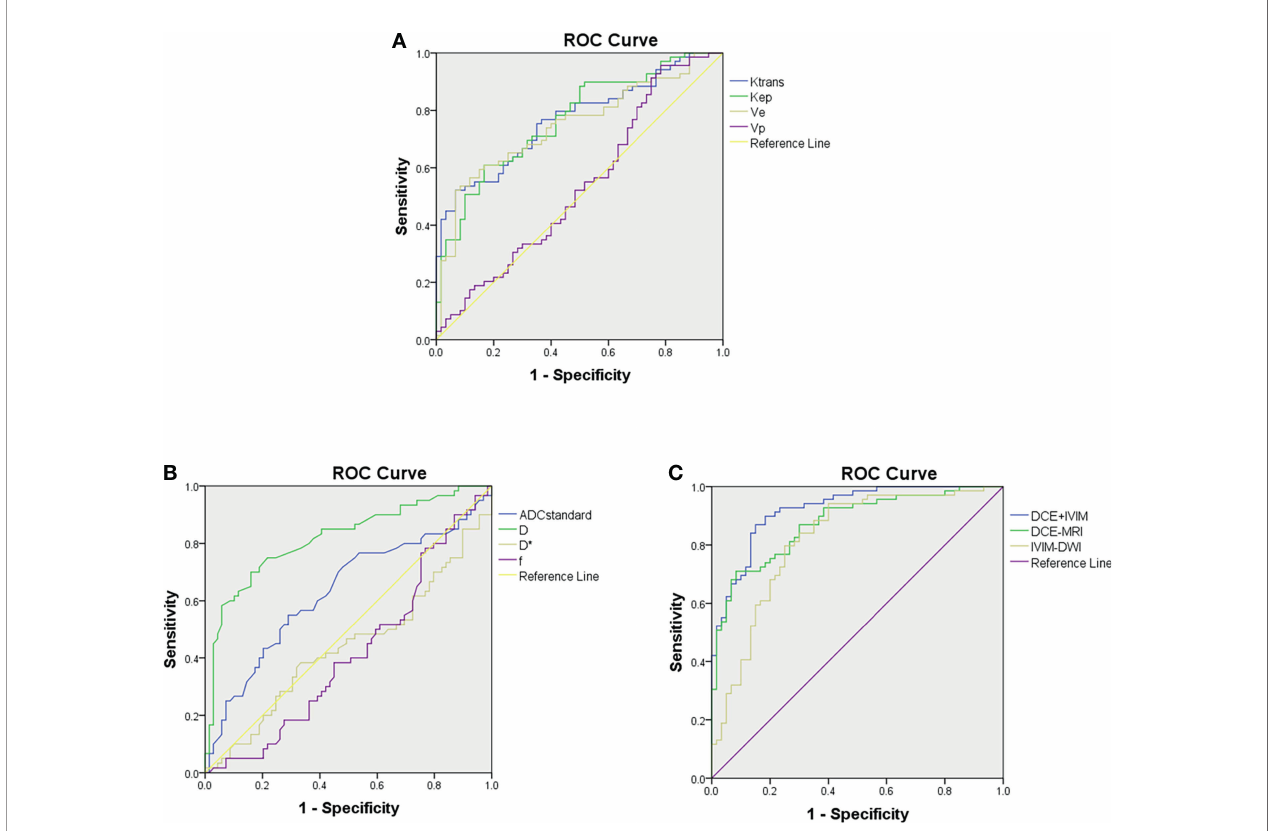
FIGURE 5 | Receiver operating characteristic curves for predicting treatment response to neoadjuvant therapy. (A) Comparison of diagnostic performance using dynamic contrast-enhanced (DCE) MRI parameters. (B) Comparison of diagnostic performance using intravoxel incoherent motion (IVIM) parameters. (C) Comparison of diagnostic performance using combined model of DCE-MRI and